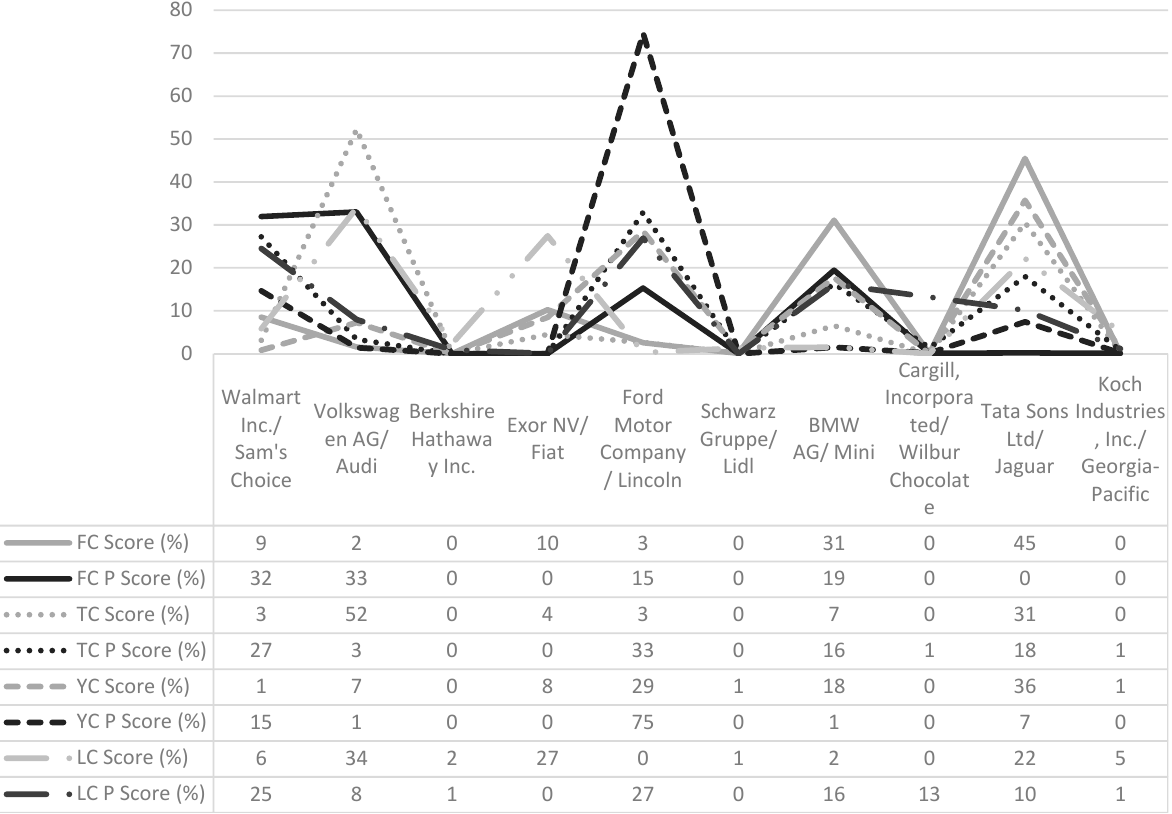
Scheme 1. Visualization of the social media strength; Brands vs. their parent companies. The analyzed data have been the subject of extensive